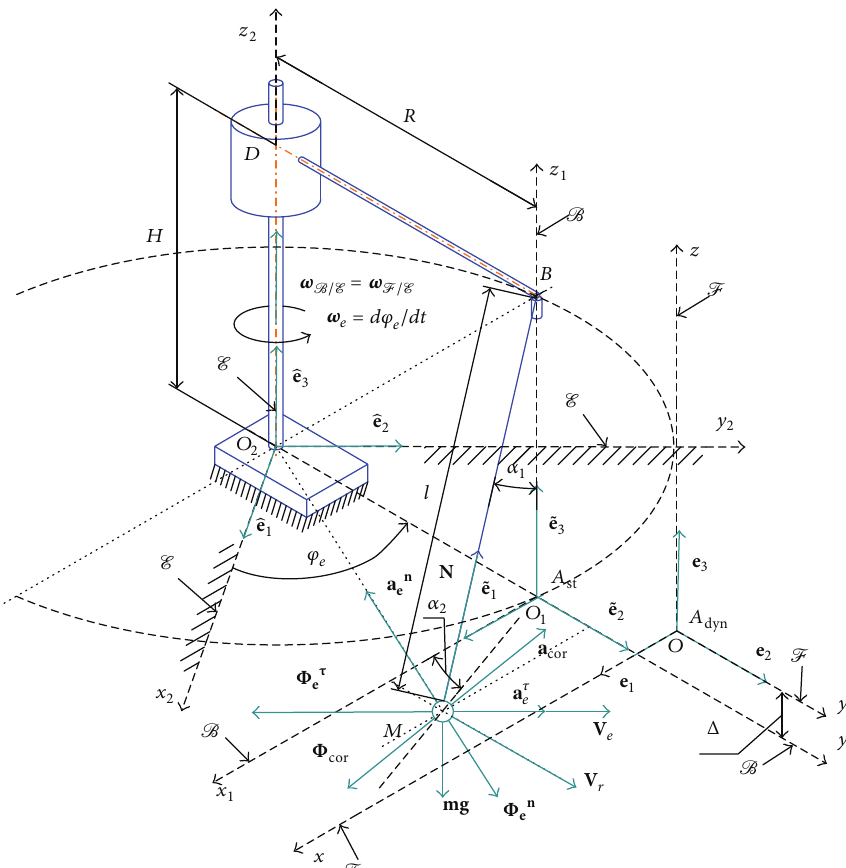
Figure 10: Computational spatial scheme of spherical pendulum 𝑀 , swaying on the cable 𝑀𝐵 during crane boom 𝐵𝑂 2 slewing motion for the nonlinear model derivation in Cartesian